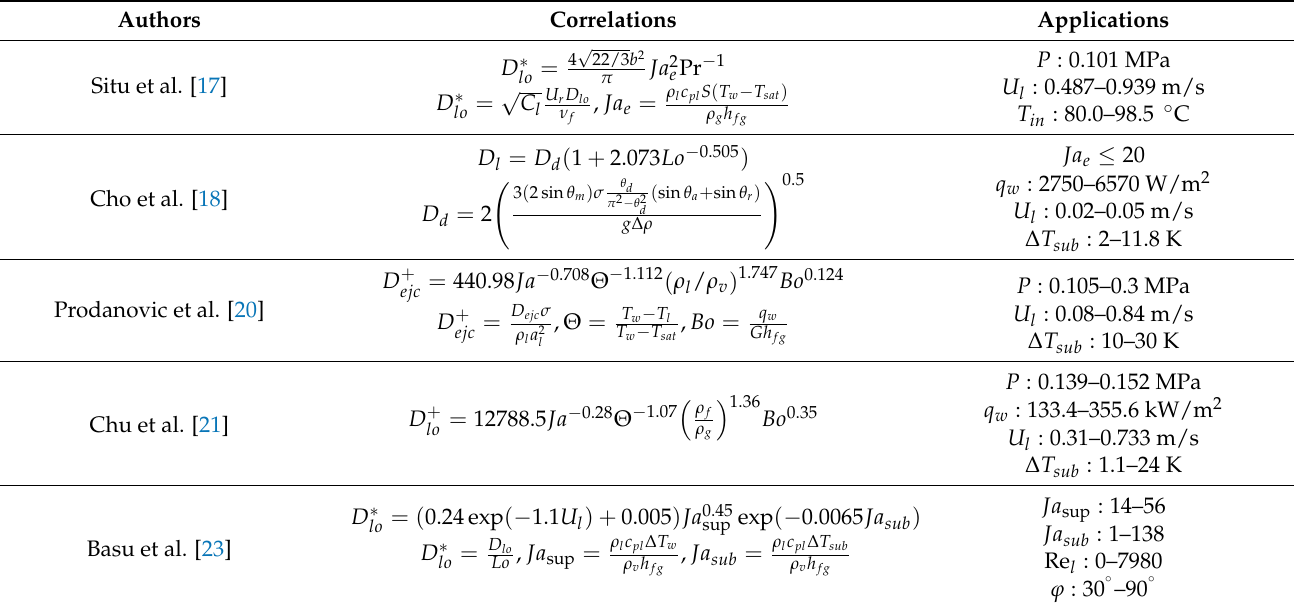
Table 1. Models of bubble lift-off diameter in vertical subcooled boiling